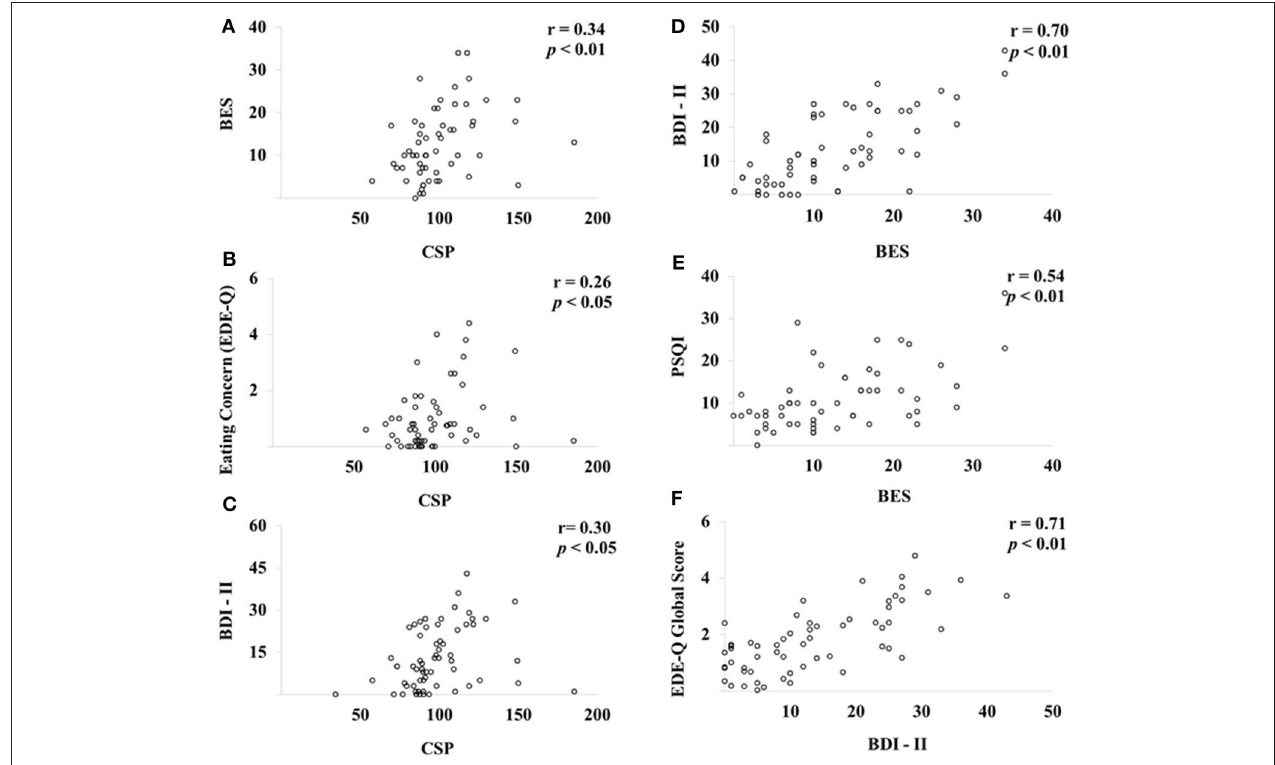
FIGURE 3 | Pearson’s correlation analysis among CSP, eating behavior, and inhibitory control through the Go/No-Go paradigm. Scatter plots of CSP, eating behavior, and Go/No-Go paradigm ( n = 60). BES, Binge Eating Scale; CSP, cortical silent period; BDI-II, Beck Depression Inventory; PSQI, Pittsburgh Sleep Quality Index; EDE-Q, Eating Disorder Examination Questionnaire. The CSP was positively correlated with BES (A) , Eating Concern (B) and BDI-II (C) , while the BES was positively correlated to BDI-II (D) and PSQI (E) . BDI-II was positively associated with the EDE-Q global score (F)